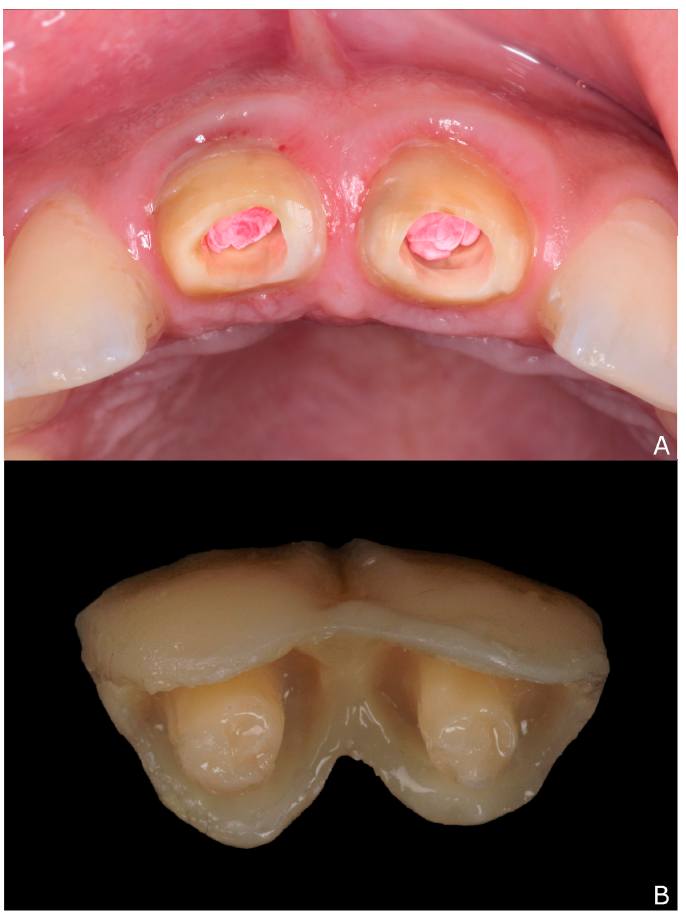
Figure 4. Temporary endocrown fabrication: ( A ) Teflon tape inside the canals act as stopper for the temporary resin material; and ( B ) temporary endocrowns.